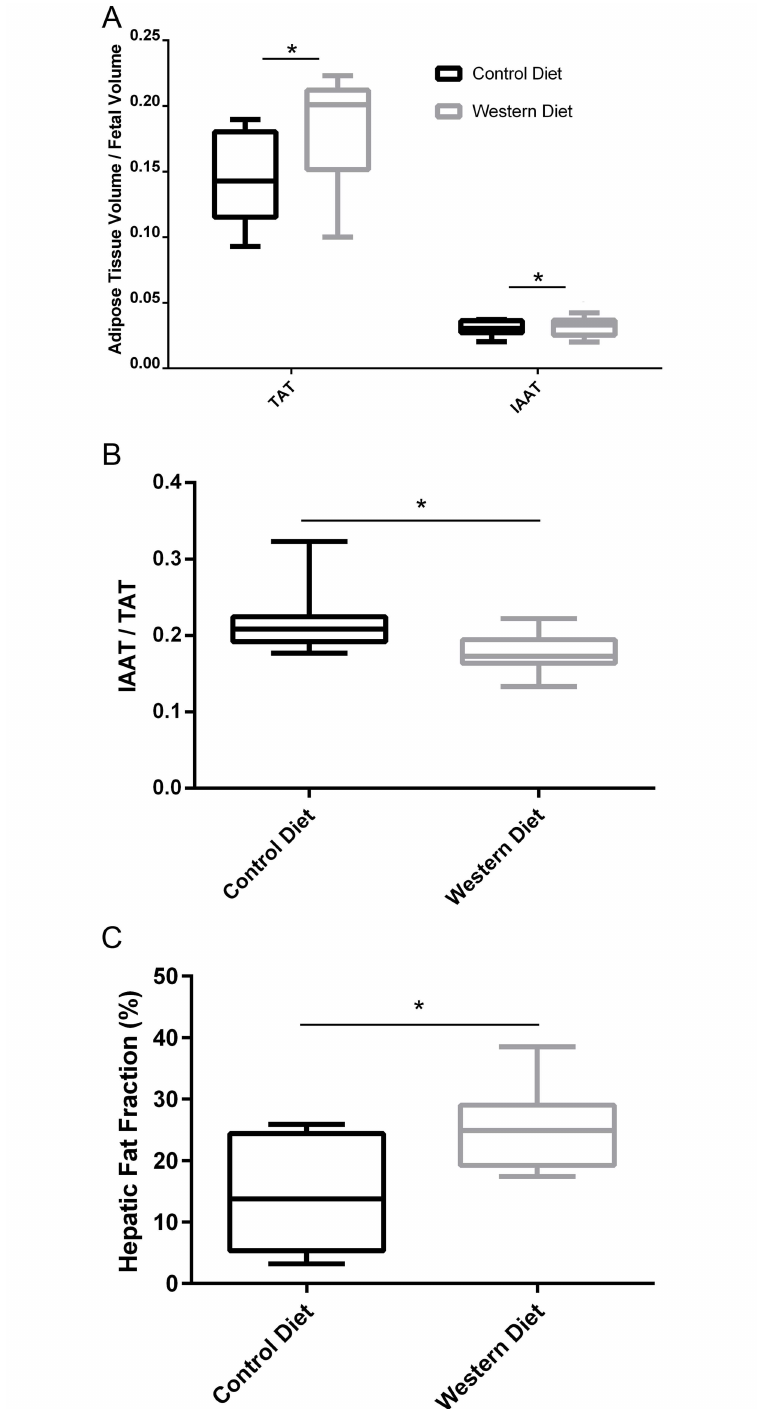
Fig 5. Fetal fat deposition for Control Diet and Western Diet fetuses. (A) Total adipose tissue (TAT) to fetal volume ratio and intra-abdominal adipose tissue (IAAT) volume to fetal volume ratio. (B) IAAT to TAT volume ratio. (C) Fetal hepatic proton density fat fraction. Data are presented as box and whisker plots as described in the methods section for CD (black) and WD (grey) fetuses. n = 11 and 9 for CD and WD, respectively. (cid:3) P < .05.